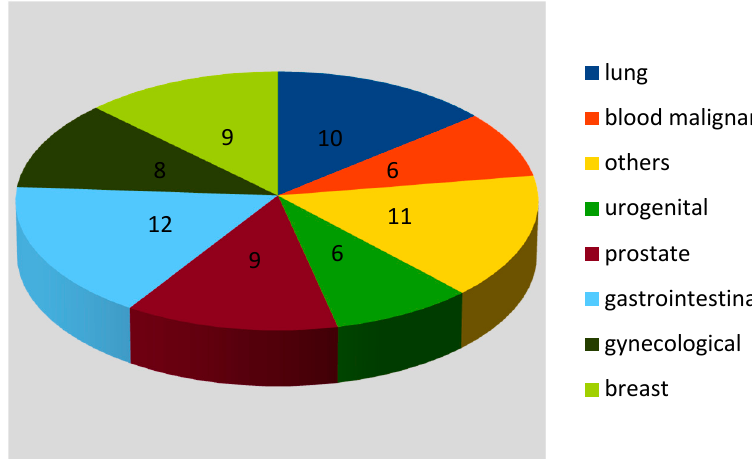
Figure 1. Type of malignancy (number of patients).